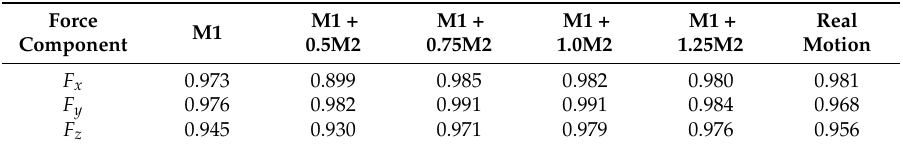
Table 1. Linear correlation coefficients between the aerodynamic forces and the dynamic pressure forces at baseline forward speed (2.67 m/s).